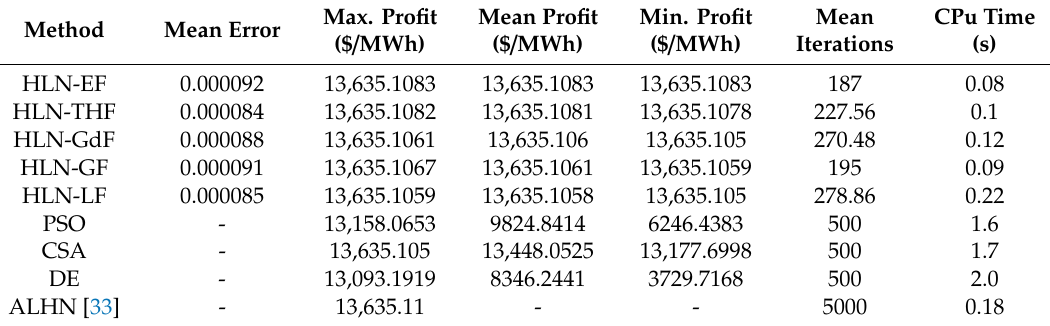
Table 4. Comparison of results obtained for the 10-unit system with the second revenue model.